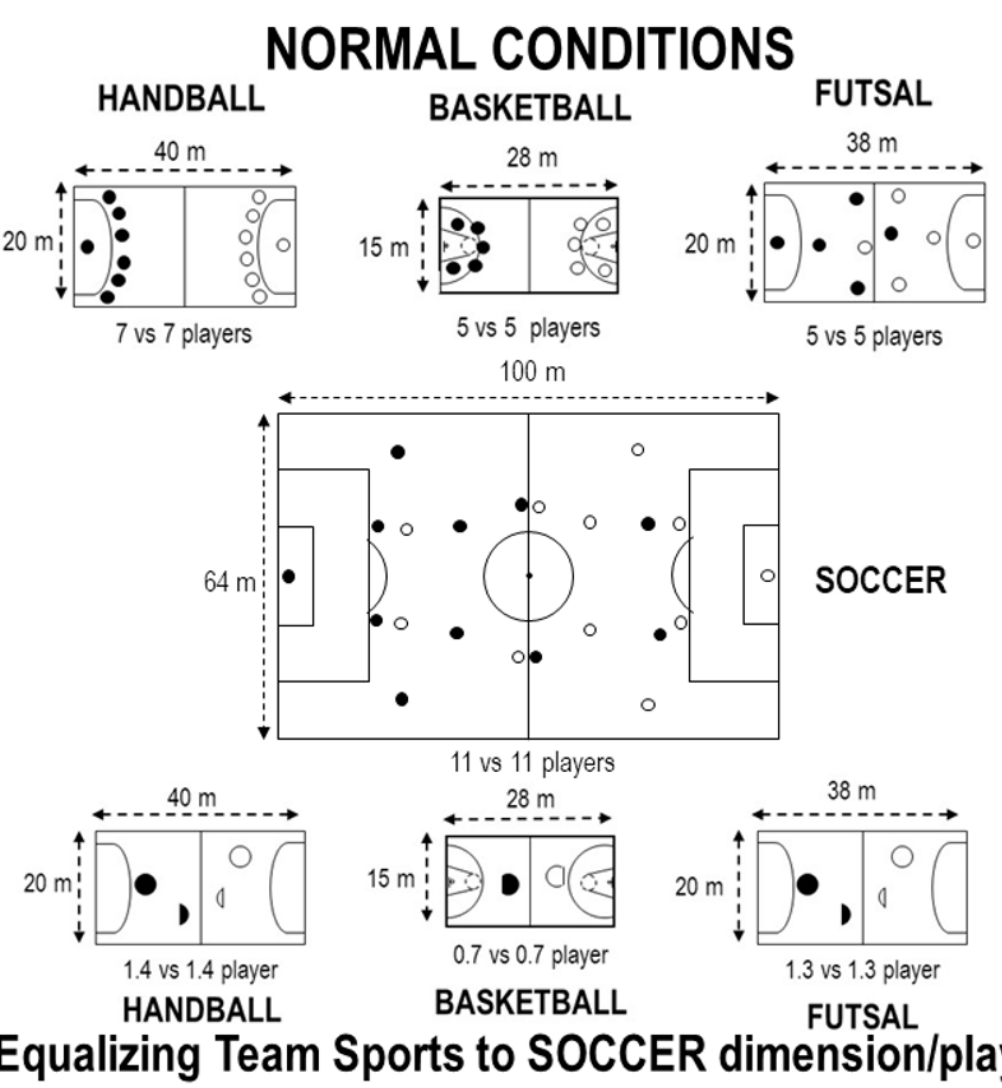
Figure 1. Regular dimensions and number of players on the field / court (top). At the bottom, simulations to equate soccer (~291 m 2 / player) to other team sports’ dimensions by decreasing the number of players (i.e., handball, basketball and futsal).